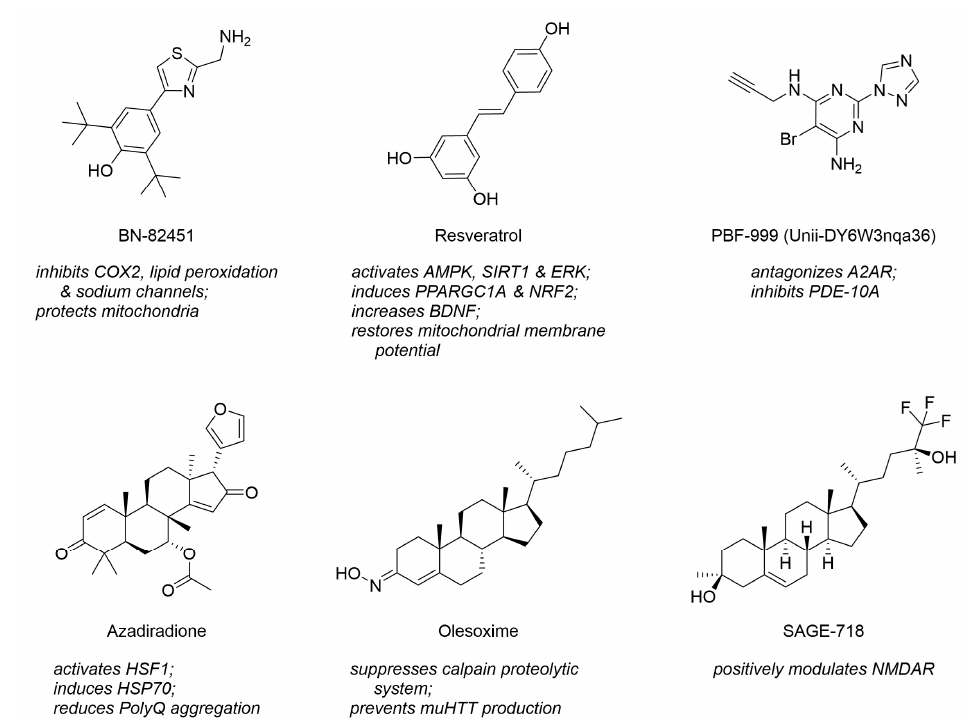
Figure 11. Molecular formulae of polypharmaceutics and polypharmacological compound classes that stretch their biological activity over a range of diverse HD-related pharmacological targets and pathways.